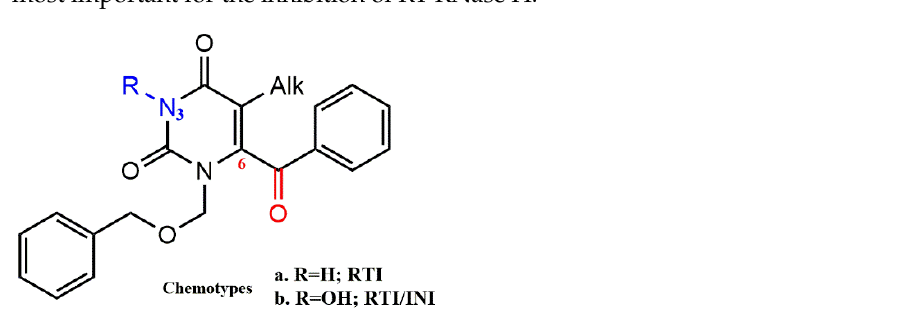
Figure 12. Design of the new N-3-hydroxypyrimidine-2,4-dione derivatives presenting a C-6 benzoyl group.